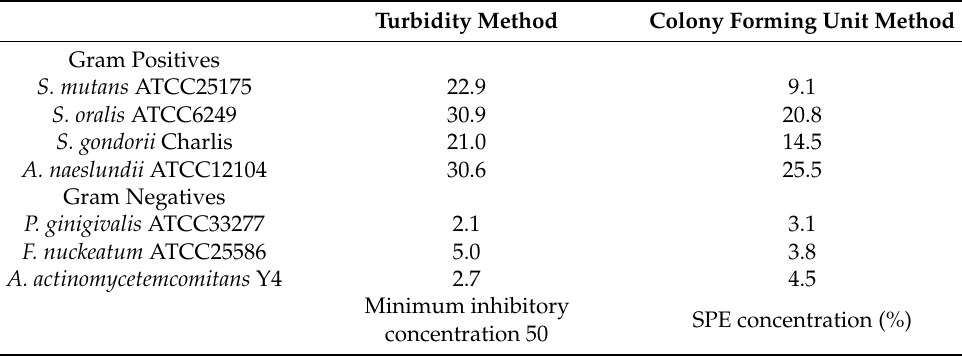
Table 1. Minimum inhibitory concentration (MIC) 50 SPE concentration in culture medium. MIC50 calculated from the results of the turbidity method and colony forming method of each strain is